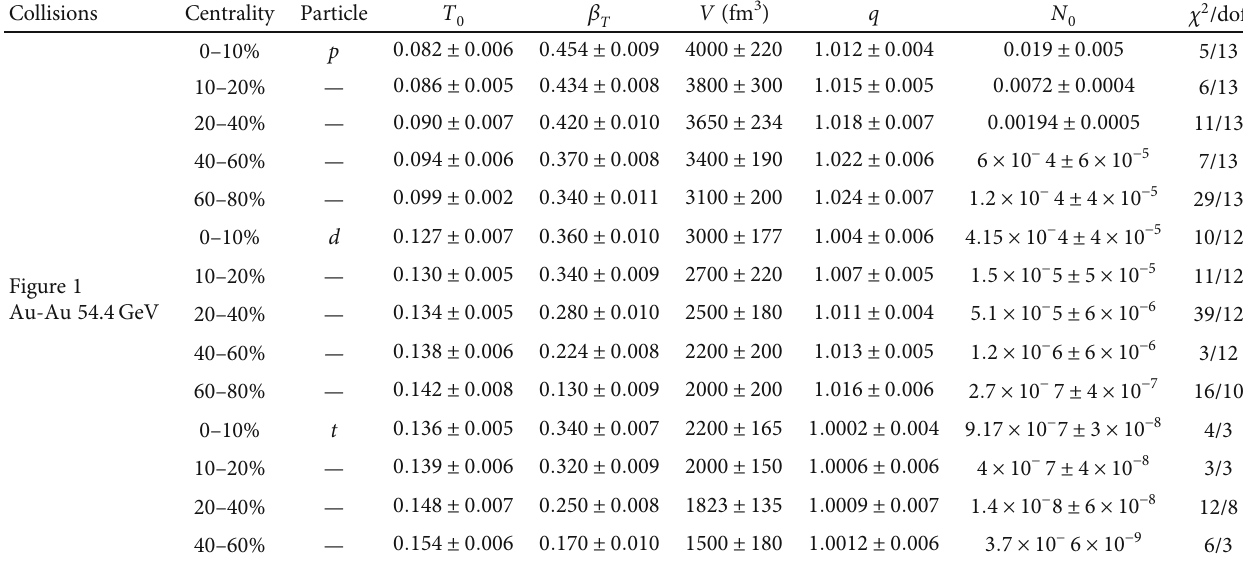
Table 1: Values of free parameters ( T corresponding to the curves in Figures 1.